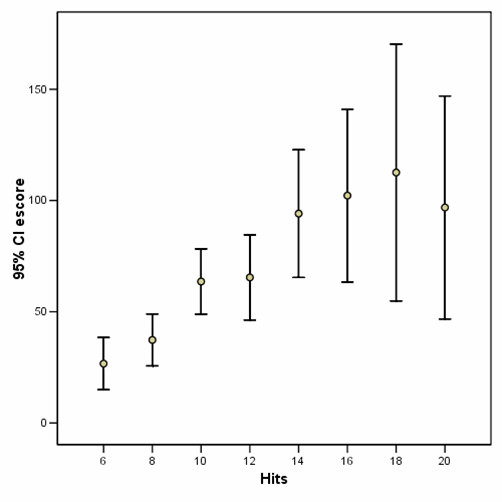
Confidence intervals for expect (e) values between soybean sequences and A. thaliana genomic sequence, based on the number of 7 bp hits in addition to an initial 15 bp identity (SPSS Inc., Chicago, Illinois). For each category, a total of twenty, randomly selected matches sharing the same number of additional, identical 7 bp hits were compared using the BLAST2Seq utility on NCBI. The e-score values reported are those between the soybean sequences and the A. thaliana chromosome region indicated by the BLAST2seq program. For instance, when 10 additional 7 bp matches are identified by our algorithm, 95% of the short soybean sequences identified as similar to an A. thaliana genomic region had e values between e-50 and e-80 when these two sequences were compared on NCBI.